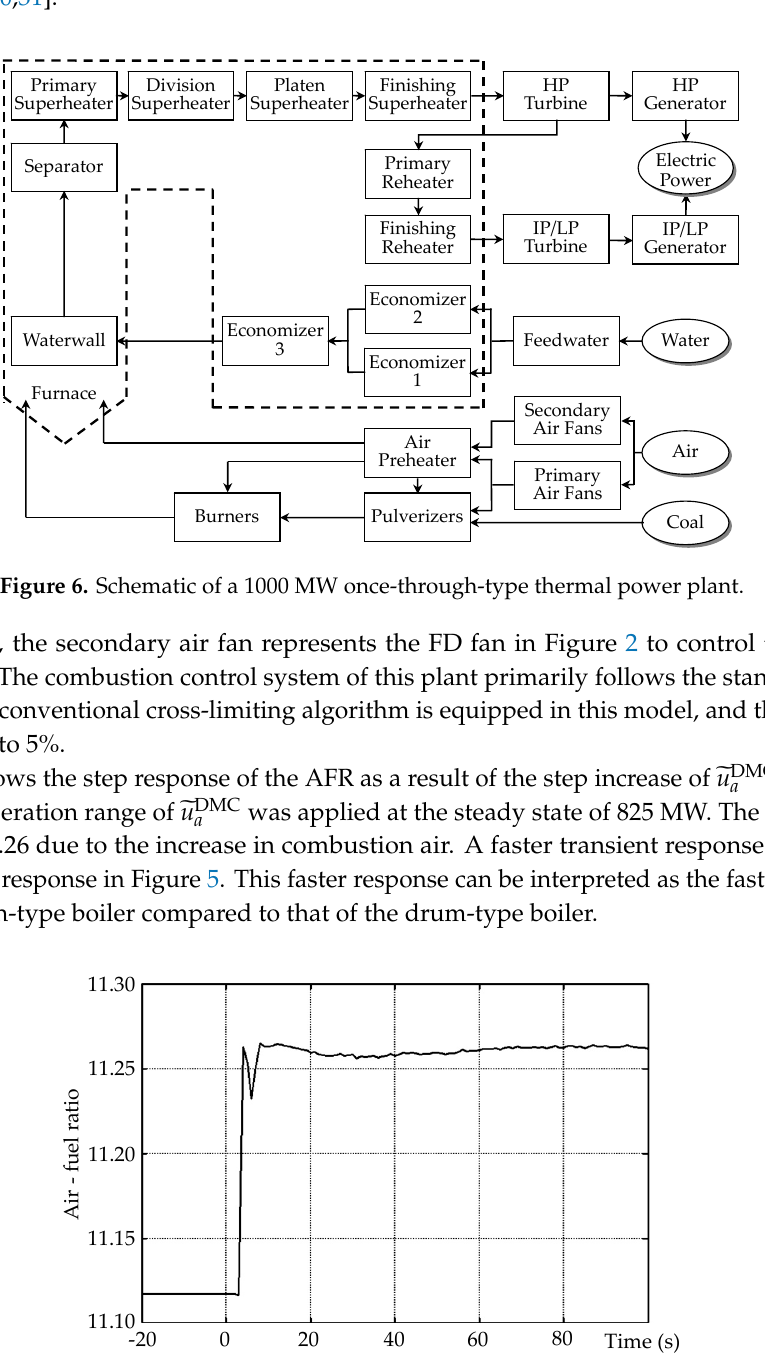
Figure 7. Response of air–fuel ratio in 1000 MW plant due to step increase of  DMC